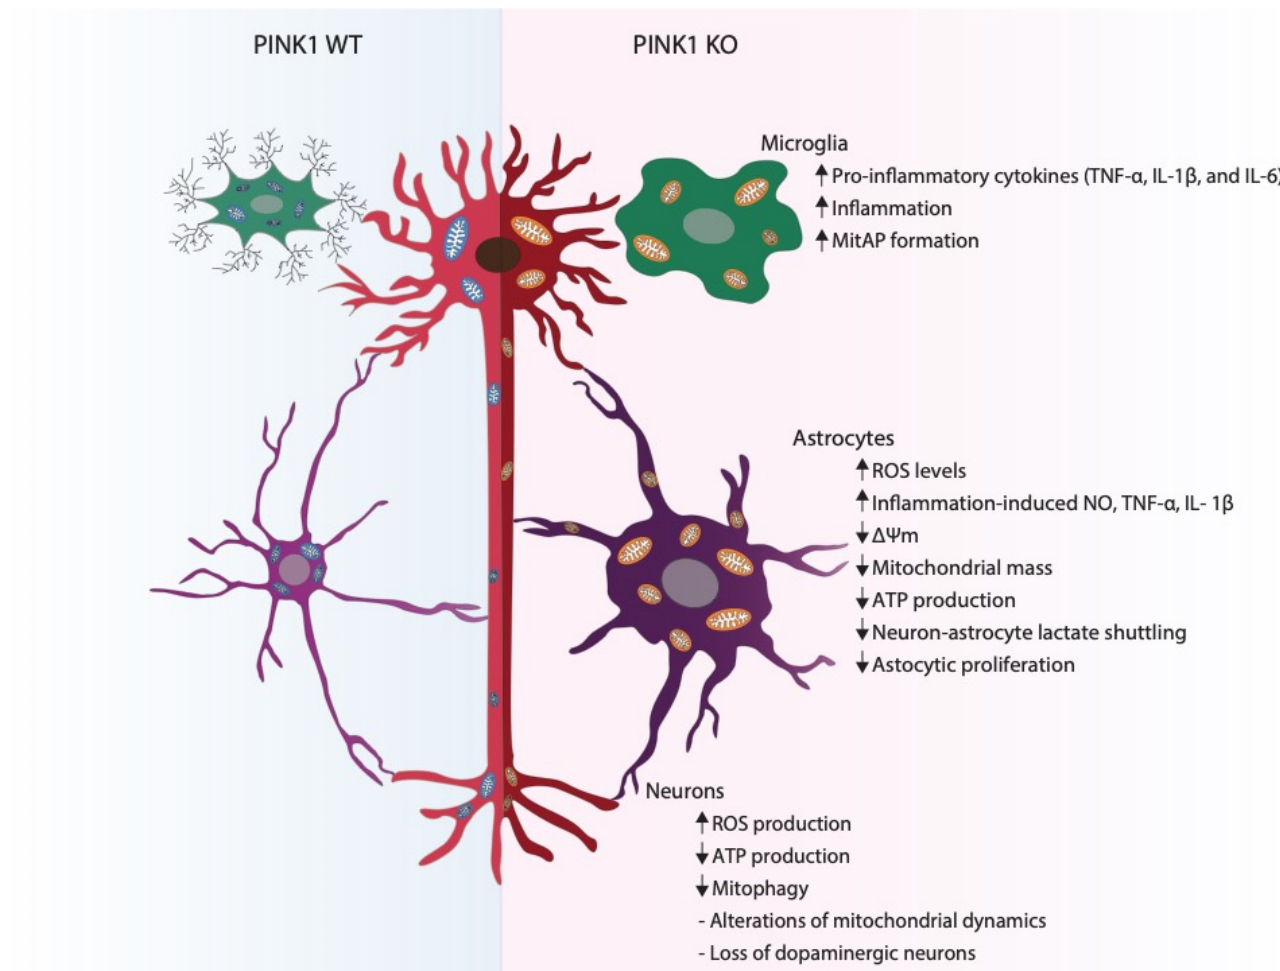
Figure 1. Impact of PINK1 deficiency in neural cells. When compared with PINK1 WT, PINK1 KO microglia shows an increase in the pro-inflammatory release of the cytokines TNF- α , IL-1 β and IL-6, consequently leading to an increase in overall brain inflammation. Additionally, in the absence of PINK1, an increase in mitochondrial antigen presentation (MitAP) occurs, indicating an activation of autoimmune mechanisms. In astrocytes lacking PINK1, an increase in reactive oxygen species (ROS), inflammation-induced nitric oxide (NO) levels and TNF- α and IL-1 β production has been observed, while a decrease in mitochondrial membrane potential ( Δ ψ m), mitochondrial mass, ATP production and glucose-uptake capacity occurs. These alterations prime a decreased astrocytic proliferation ability. In neurons, PINK1 loss-of-function leads to a decrease in ATP production and mitochondrial clearance, as well as an increase in ROS production. Absence of PINK1 also alters mitochondrial dynamics. All these alterations lead to an ultimate loss of dopaminergic neurons.